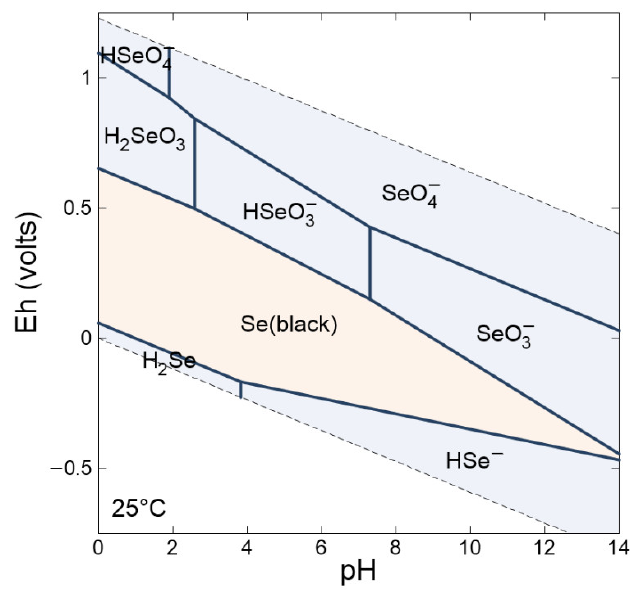
Figure A25. Low selenium 0.1 mg/L, Ca 5 mM (200 mg/L), bicarbonate 7 mM (427 mg/L), sulfate 4 mM (384 mg/L), and chloride 2 mM (71 mg/L).